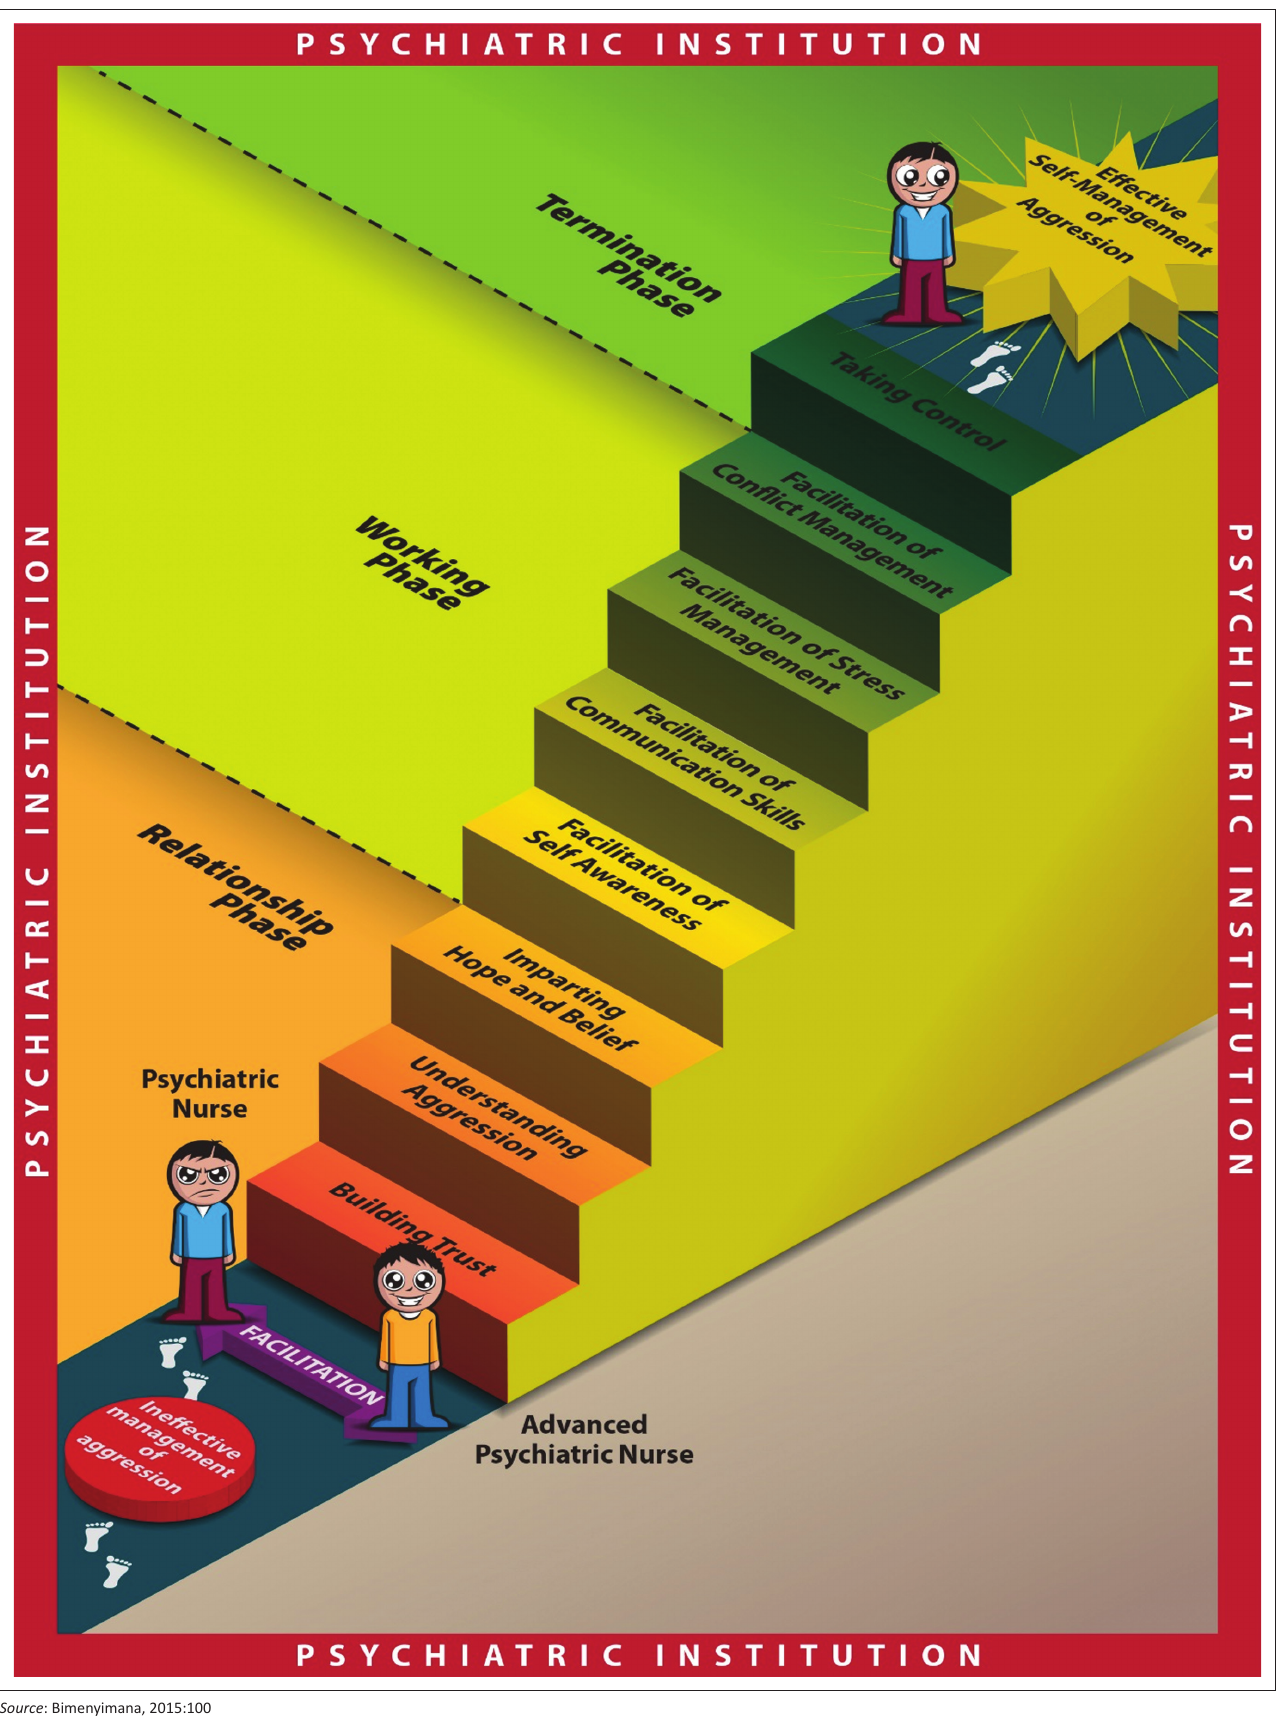
FIGURE 1: A model to facilitate effective self-management of